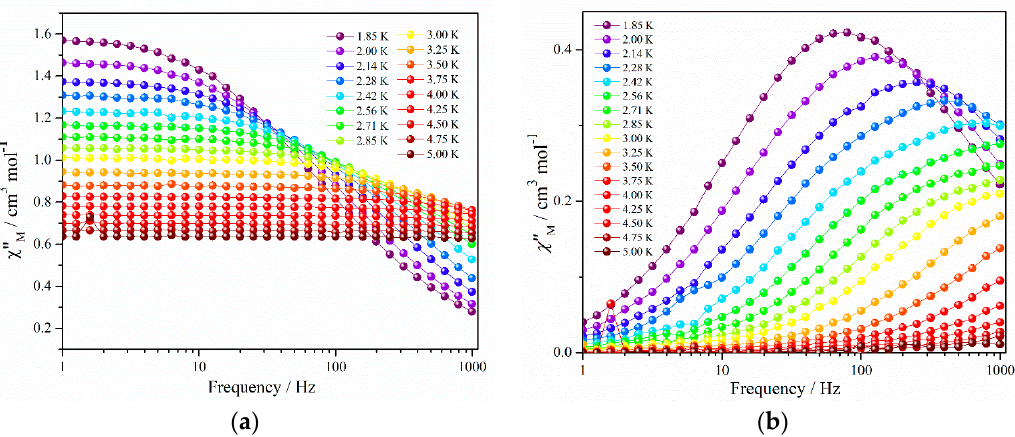
Figure 3. Frequency dependence of the ( a ) in phase and ( b ) out of phase components of the ac magnetic susceptibility for complex 1’ under 1000 Oe dc field.